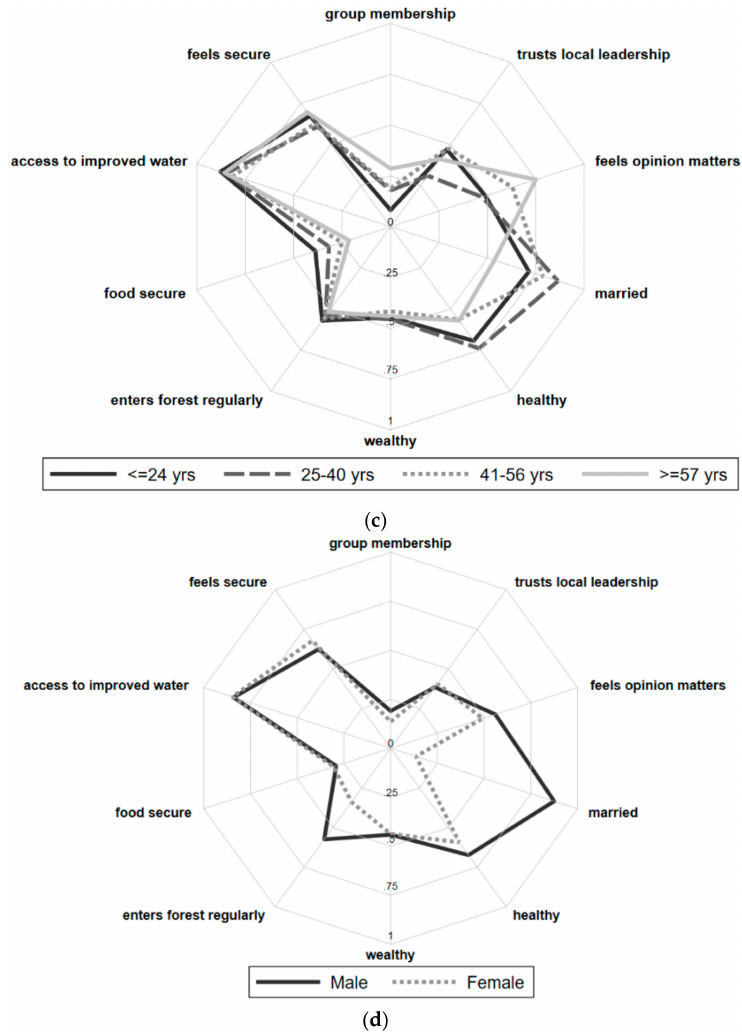
Figure 1. Spider plots of key variables by community. ( a ) key factors by community; ( b ) key factors by migration status (years in community); ( c ) key factors by age of head of household; ( d ) key factors by sex of head of